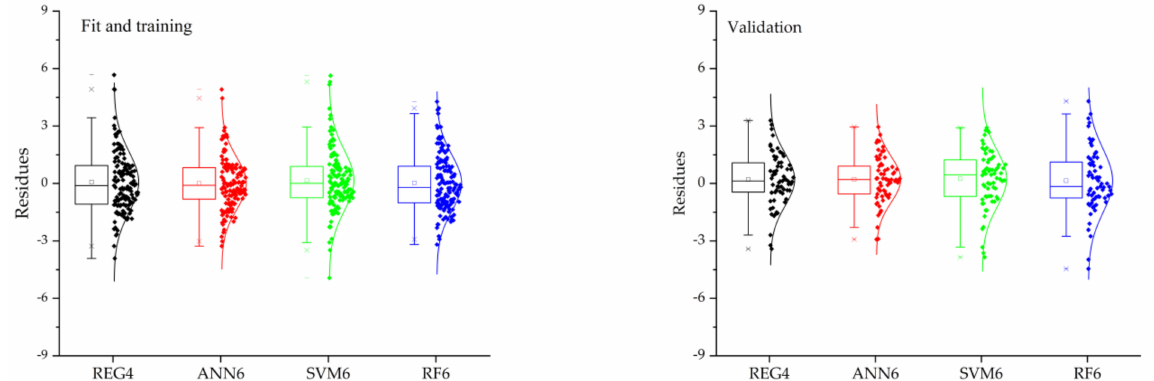
Figure 9. Residual analysis of crown diameter models according to the techniques analyzed in fit-training and validation data in which REG4 refers to the regression model 4; ANN6, to artificial neural network 6; SVM6, to support vector machine 6; and RF6, to random forest